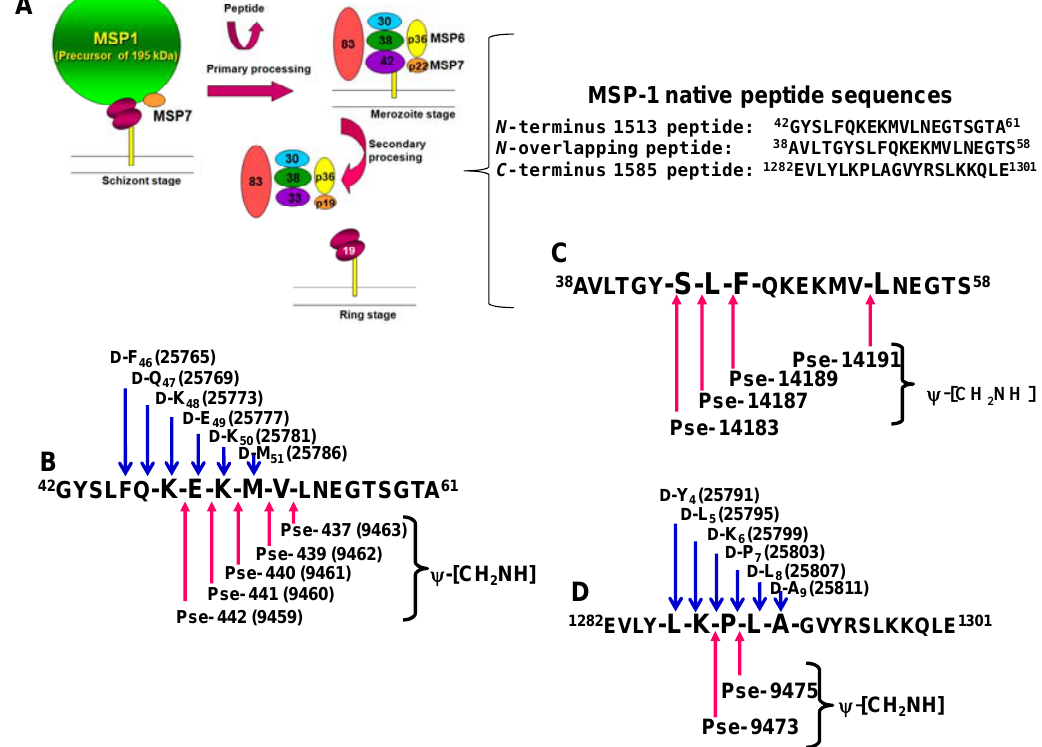
Figure 2. The Plasmodium falciparum MSP-1 antigen, as a model for pseudopeptide and peptido-mimetic designing. A . MSP-1 proteolytic processing to produces a non-covalent complex on the parasite membrane surface during malarial infection of RBCs. B. MSP-1 42- 61 N -terminus HABP coded 1513 template sequence, for isoster bond and D-partially substituted analogue design. C. MSP-1 38-58 template sequence and its designed isoster bond analogues. MSP-1 1282-1301 C -terminus sequence HABP coded 1585 template sequence, for isoster bond and D-partially substituted analogue design. Codes for each pseudopeptide were arbitrary assigned to avoid using nomenclature for L - and D - enantiomers. - NH represents a reduced amide isoster CH 2